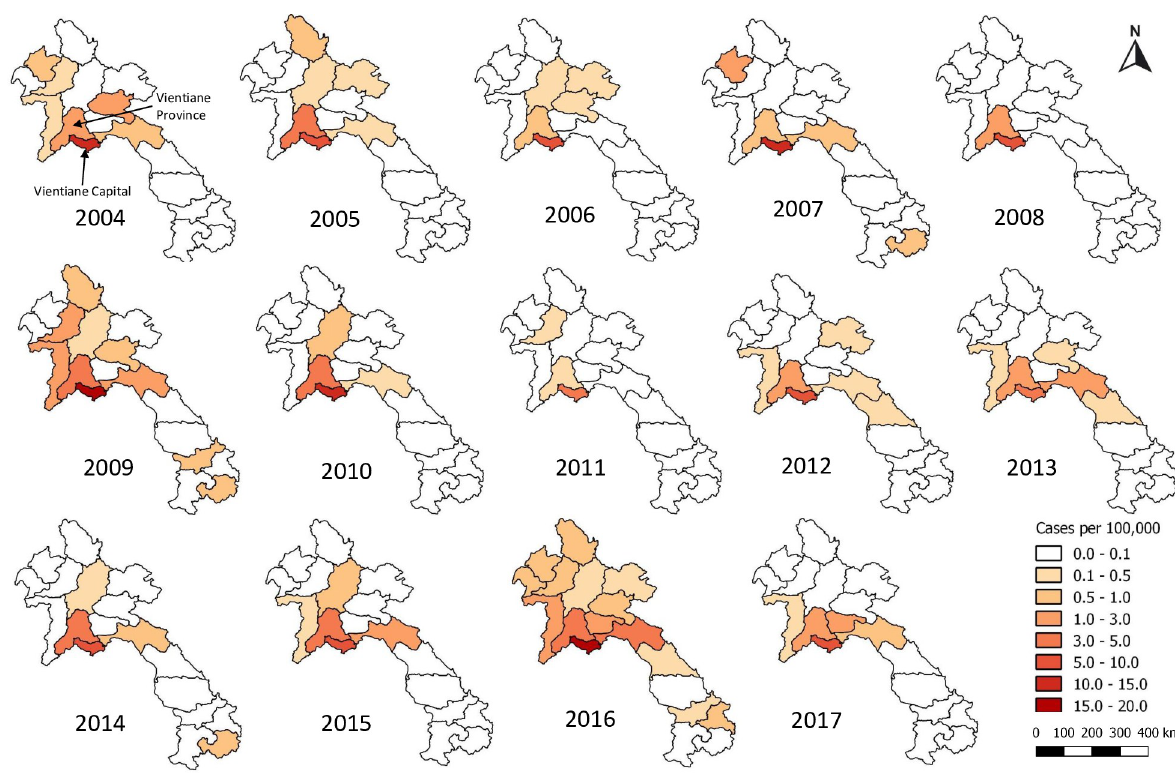
Fig 2. Patients with murine typhus per 100,000 people per province in Laos from 2004–2017. Maps were created using QGIS version 3.4.9. All layers were created by the authors of this